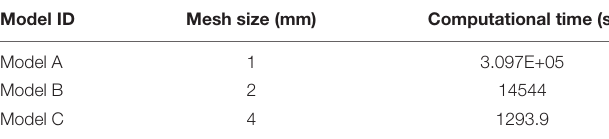
TABLE 1 | Computational performance of different mesh